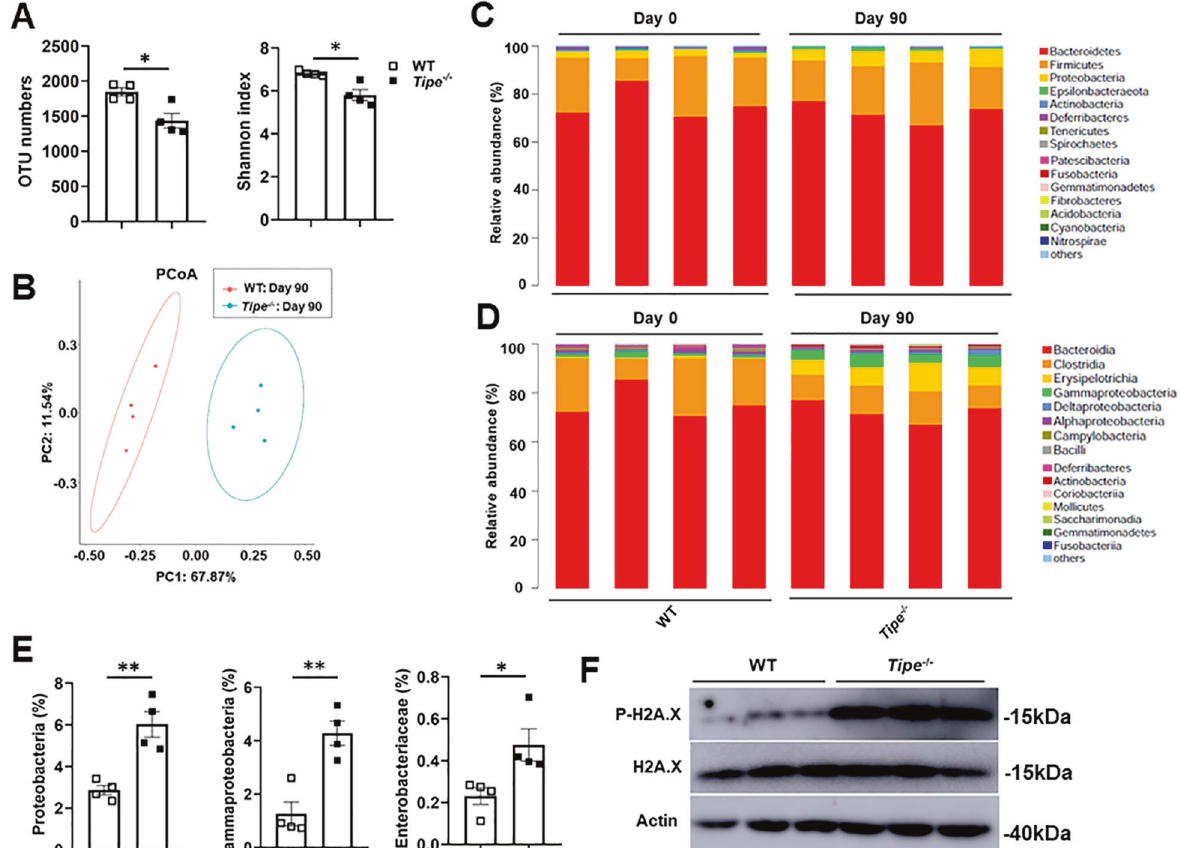
Fig. 4 The intestinal microbiota is altered in tumor-bearing Tipe − / − mice. A Operational taxonomic unit (OTU) abundances (left) and Shannon-Wiener diversity index (Shannon index) (right) of the feces from WT ( n = 4) and Tipe − / − ( n = 4) mice on day 90 of the CAC model by 16S rRNA sequencing. B PCoA analysis of microbiome in the feces from WT ( n = 4) and Tipe − / − ( n = 4) mice on day 90 of the CAC model by 16 S rRNA sequencing. C , D Relative abundance of microbiota at the top 15 phylum level ( C ), or the top 15 class level ( D ) in the feces by taxon- based analysis as in ( A ) ( n = 4 per group). E Quanti fi cation analyses of Proteobacteria phylum, Gammaproteobacteria class and Enterobacteriaceae family microbiota distribution in the feces as in ( A ) ( n = 4 per group). F Western blot analysis of p-H2A.X in WT ( n = 3) and Tipe − / − ( n = 3) colon tumors on day 90 of the CAC model. Blots represent data from the same biological samples run in parallel. Data are presented as mean ± SEM and are representative of three independent experiments. Student ’ s t test ( A and E ), * p < 0.05, ** p <